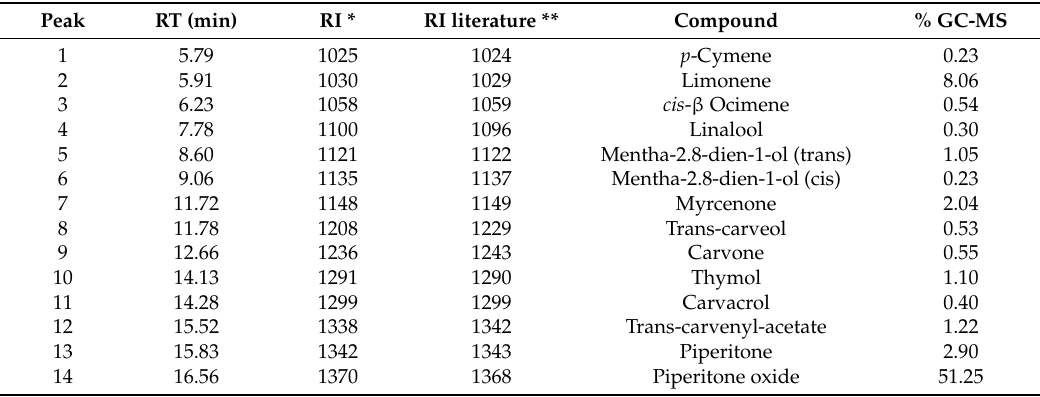
Table 1. Chemical composition of essential oil of dried leaves of Lippia schaueriana (Verbenaceae). Peak RT (min) RI * RI literature